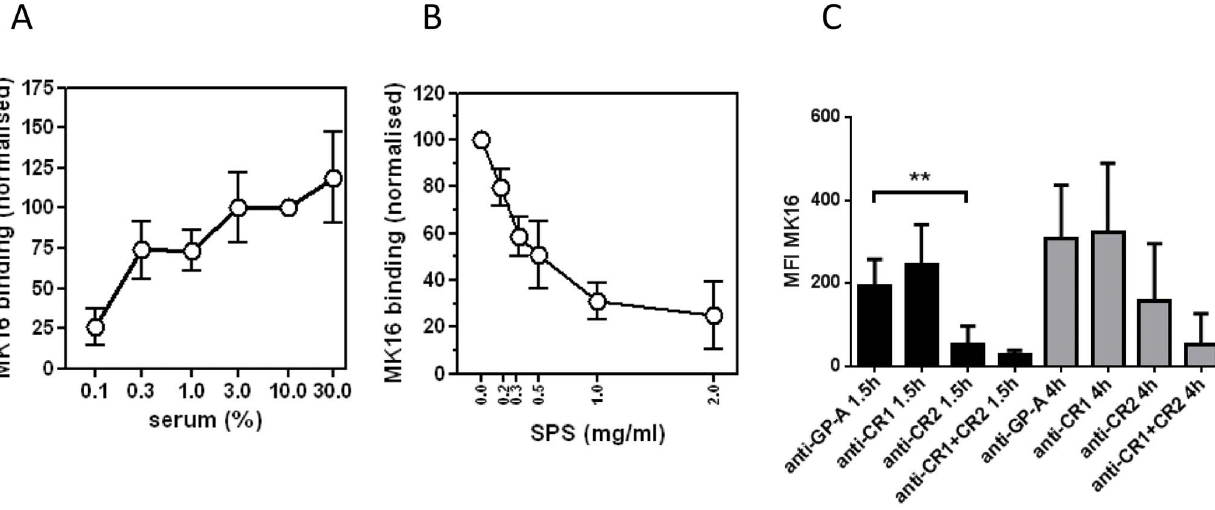
Figure 4. Influence of complement on the presentation of MBP85-99 by DR15 + B cells. PBMCs from healthy HLA-DR15 + donors were incubated for 18 h with MBP in media containing normal serum. Cells were stained with FITC anti-CD19 and biotinylated MK16, followed by streptavidin-PE. (A) The binding of MK16 at different serum concentrations is shown as mean fluorescence (MFI) values normalised to that of 10% serum, (N=4). B) Before addition of serum (30% v/v), different concentrations of the complement inhibitory compound sodium polyanethole sulphonate (SPS) were added. MFI values are shown, normalised to samples without SPS, (N=6). (C) The PBMCs were pre-incubated with the anti-CR1 mAb3D9 or polyclonal sheep anti-human CR2, or both, before addition of serum (30% v/v) and MBP. Anti-glycophorin (GP)-A was used as negative control. Data are shown as means 6 SEM, (N=4–6). **p , 0.01.